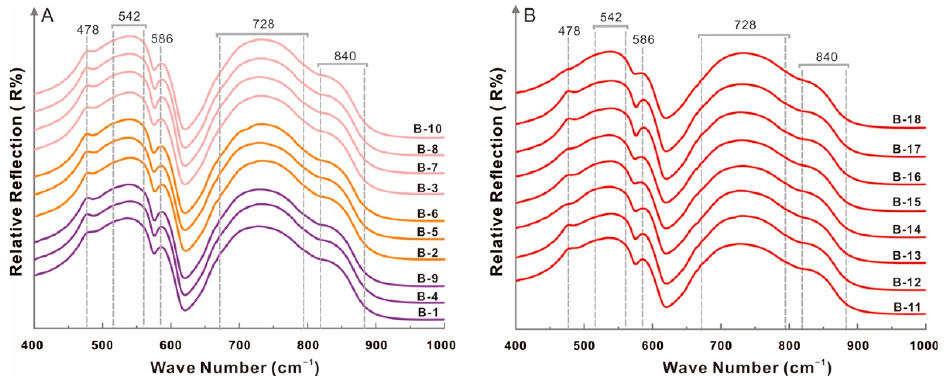
Figure 7. FTIR spectrum obtained from Mogok spinel. The marked absorption bands are related to internal Mg-O vibrations (728 cm − 1 ), Al-O vibrations (586 cm − 1 and 542 cm − 1 ) and vibration of oxygen ions (840 cm − 1 ). The line colors represent the color of the spinel samples, pink, orange and purple spinel samples are in ( A ), red spinel samples are in ( B ).